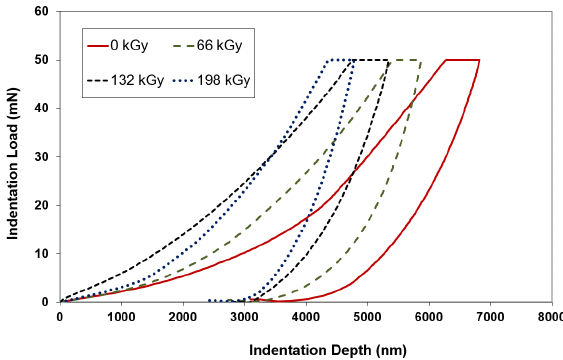
Figure 1. Indentation characteristic of tested PBT